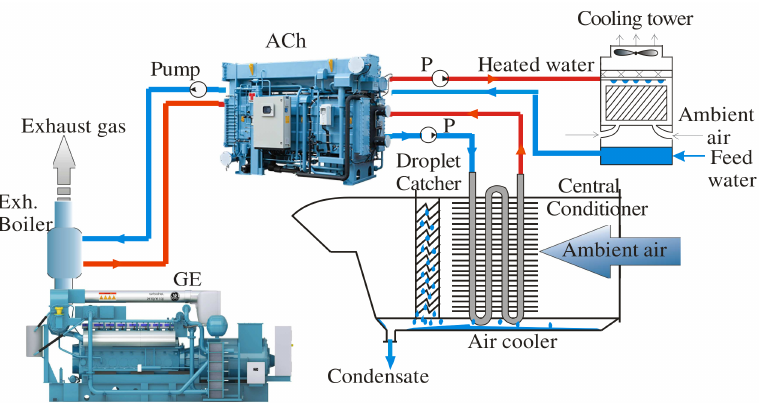
Figure 3. A scheme of a typical system of gas engine inlet air cooling in the central conditioner by chilled water from an ACh.